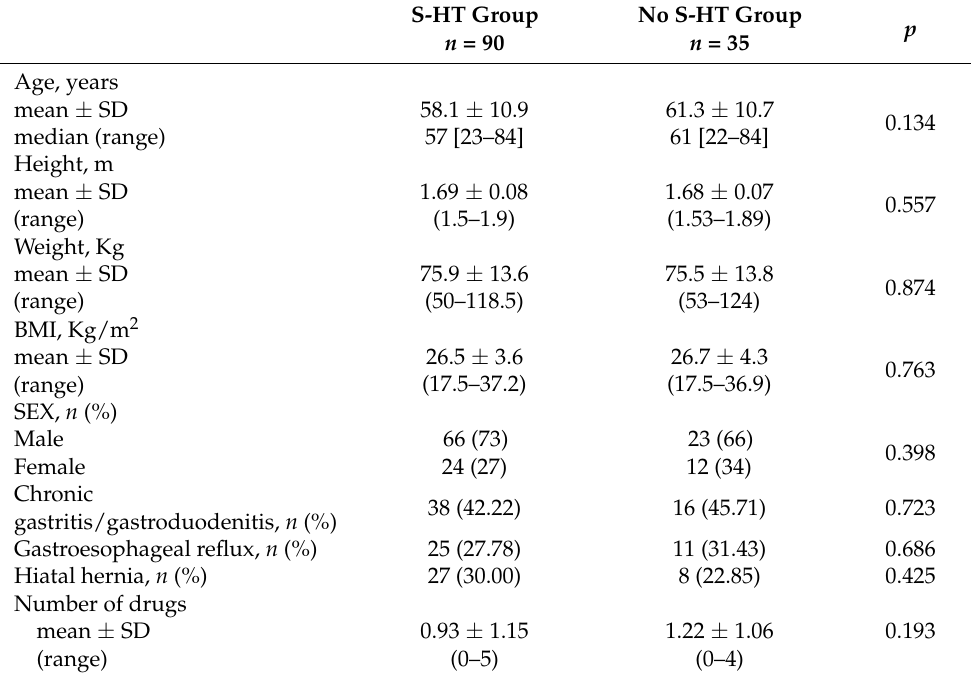
Table 1. Main characteristics of the study